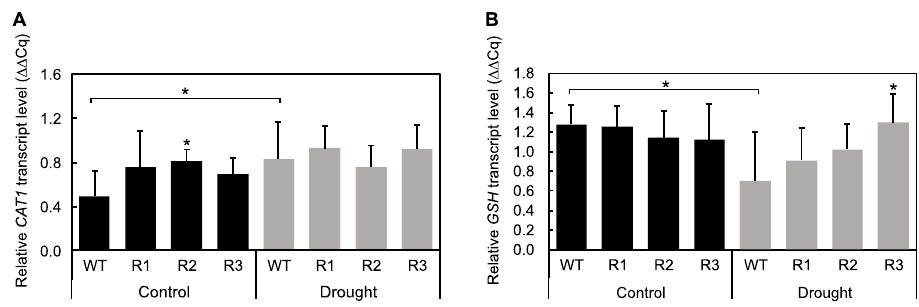
Figure 7. Impact of MsSPL9 on antioxidant activity in leaves of alfalfa WT and SPL9 -RNAi: ( A ) transcript levels of Catalase 1 (CAT1) leaves. ( B ) Transcript levels of Glutathione Synthase (GSH): the asterisks indicate significant differences within treatments (Dunnett’s test), and the bars indicate significant differences between treatments (Sidak test) in a two-way ANOVA where p < 0.05 and n = 8–10.